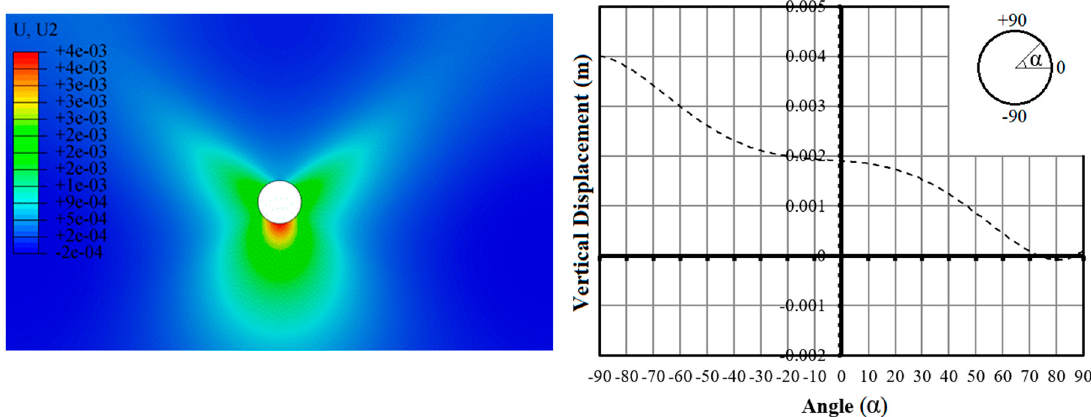
Fluids 2019 , 4 , x FOR PEER REVIEW Figure 11. Displacements in the vertical direction under steady flow conditions.